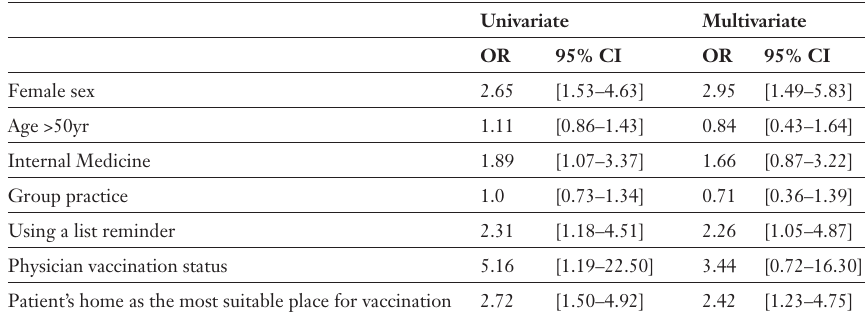
Predictors of vaccination rate >90% in logistic regression models according to clinical practice and characteristics of